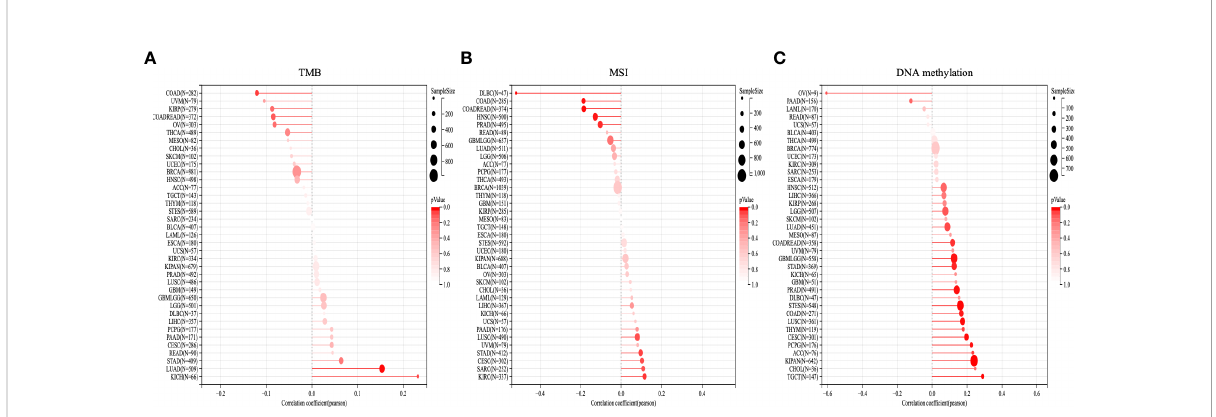
FIGURE 9 TMB, MSI, and DNA methylation analysis. The Lollipop plot represents the association between OTUD6B expression and TMB (A) , MSI (B) , and DNA methylation (C) in pan-cancer. The x-axis represents Spearman ’ s correlation coe fi cient. (TMB, tumor mutation burden; MSI, microsatellite